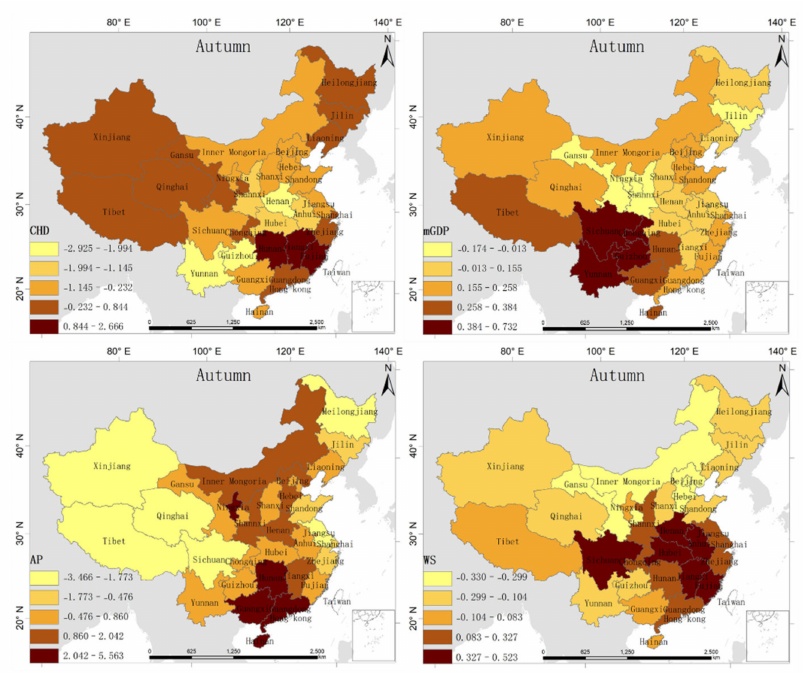
Figure 6. The spatial variations of the coefficients of the GWR model in autumn.